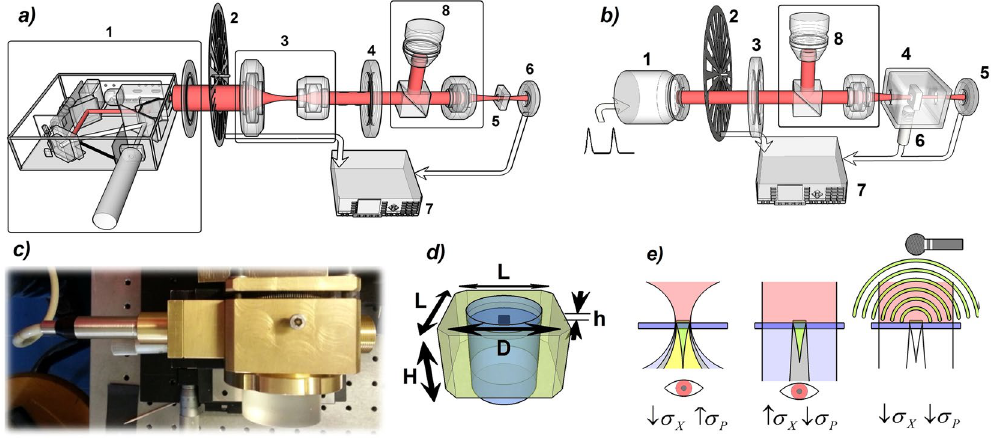
sample (5) and the photodetector (6). A lock-in (7) control the signals and a set composed of a beam splitter and a microscope (8) is adopted to visualize and correctly aim the helices. ( b ) Schematic view of the experimental setup for PA measurements. We show the laser source (1), the chopper (2), the QWP (3), the PA chamber (4) containing the studied sample and the PD (6); the microphone (6) is partially installed inside the PA chamber; here again a lock-in (7) is connected to the main set-up. ( c ) PA chamber with Mic attached on its left side. ( d ) Schematic view of the main part of the PA chamber. L = 6 cm, H = 3,5 cm, D = 4 cm, h = 1 mm. Quartz glasses specific field characters: red = laser source; yellow = transmitted light through the helices with a high incidence angle; green = transmitted light through helices with normal incidence (desired data); grey = mixed field arising both from helices’ region and nude substrate region; light grey = light purely transmitted by naked